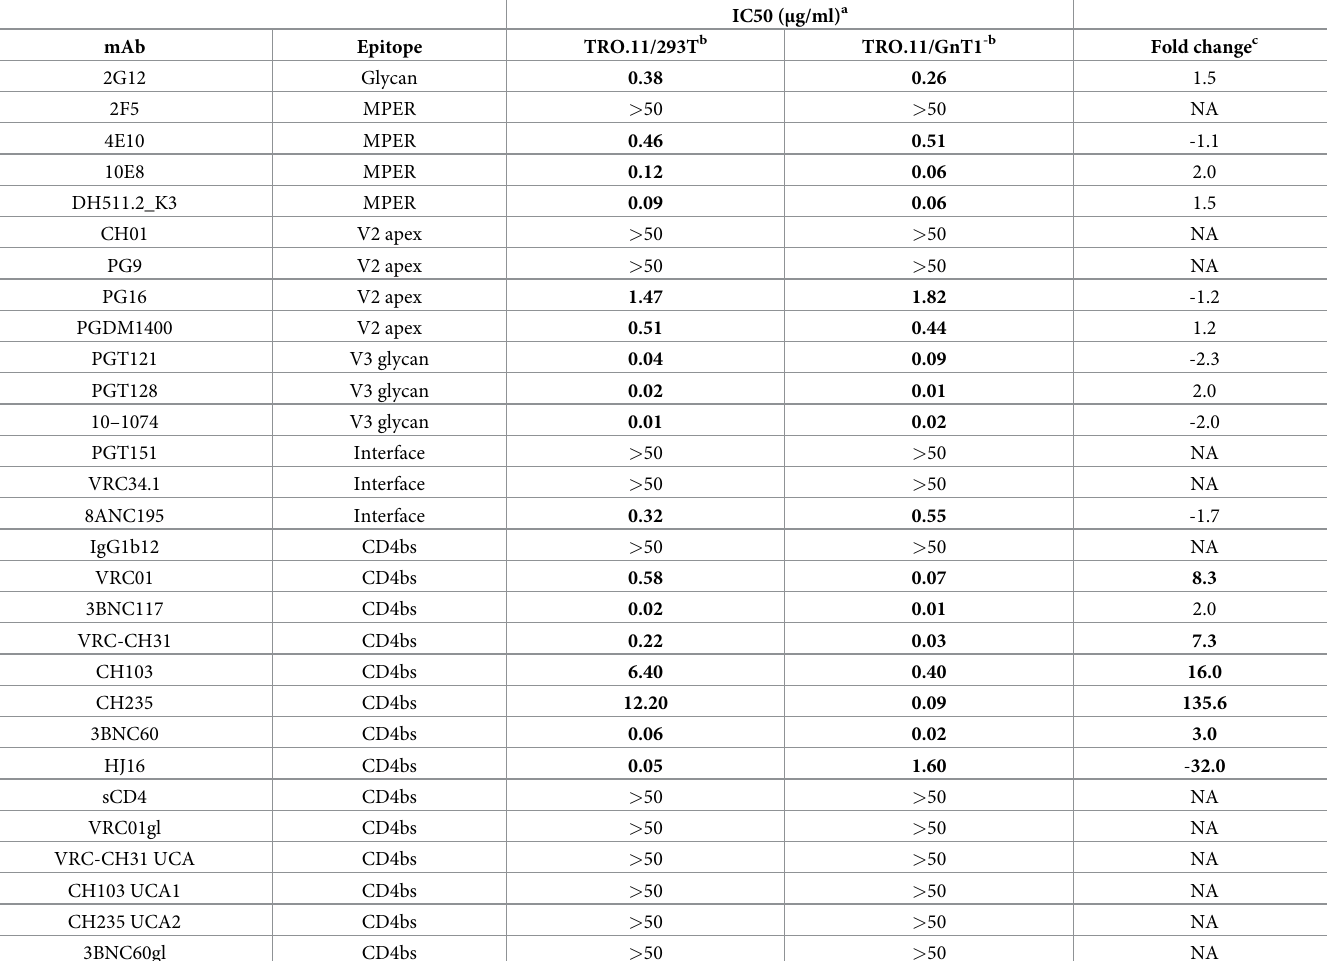
Table 2. Enhanced susceptibility of GnT1 - virus is relatively specific for CD4bs